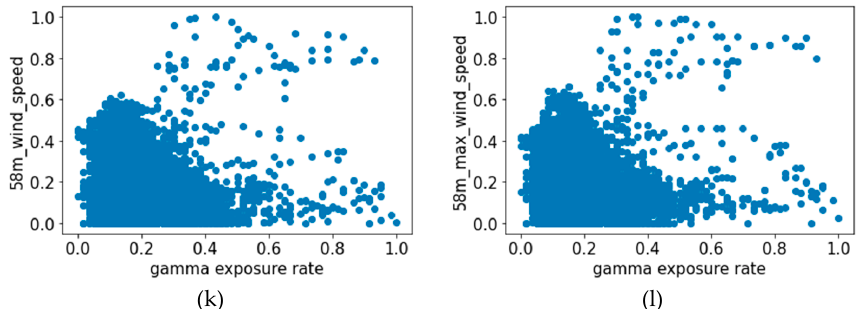
Figure 2. Scatter plot of gamma exposure rate in response to ( a ) ground temperature; ( b ) ground humidity; ( c ) rainfall; ( d ) atmospheric pressure; ( e ) 10 m tower temperature; ( f ) 10 m tower wind direction; ( g ) 10 m tower wind speed; ( h ) 10 m tower maximum wind; ( i ) 58 m tower temperature; ( j ) 58 m tower wind direction; ( k ) 58 m tower wind speed; and ( l ) 58 m tower maximum wind. Table 3. Correlation coefficient and p -value between weather data and gamma exposure rate. Weather Data Correlation Coefficient p -Value